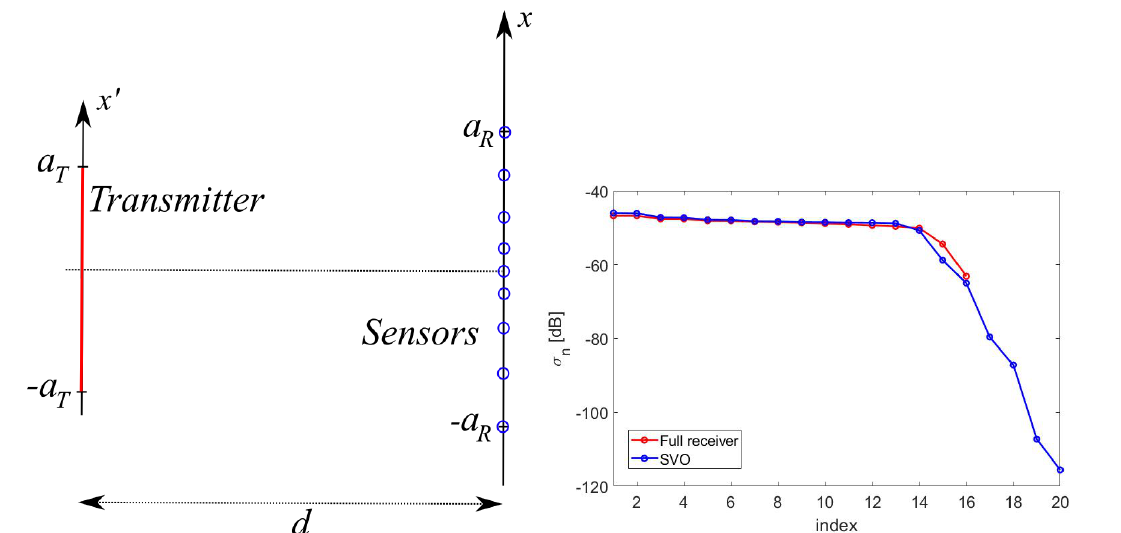
Figure 12. ( Left ): Illustrating the point-like sensor geometry without weights. ( Right ): SVO points for the case a T = 5 λ , a R = 7 λ , d = 7 λ and N =